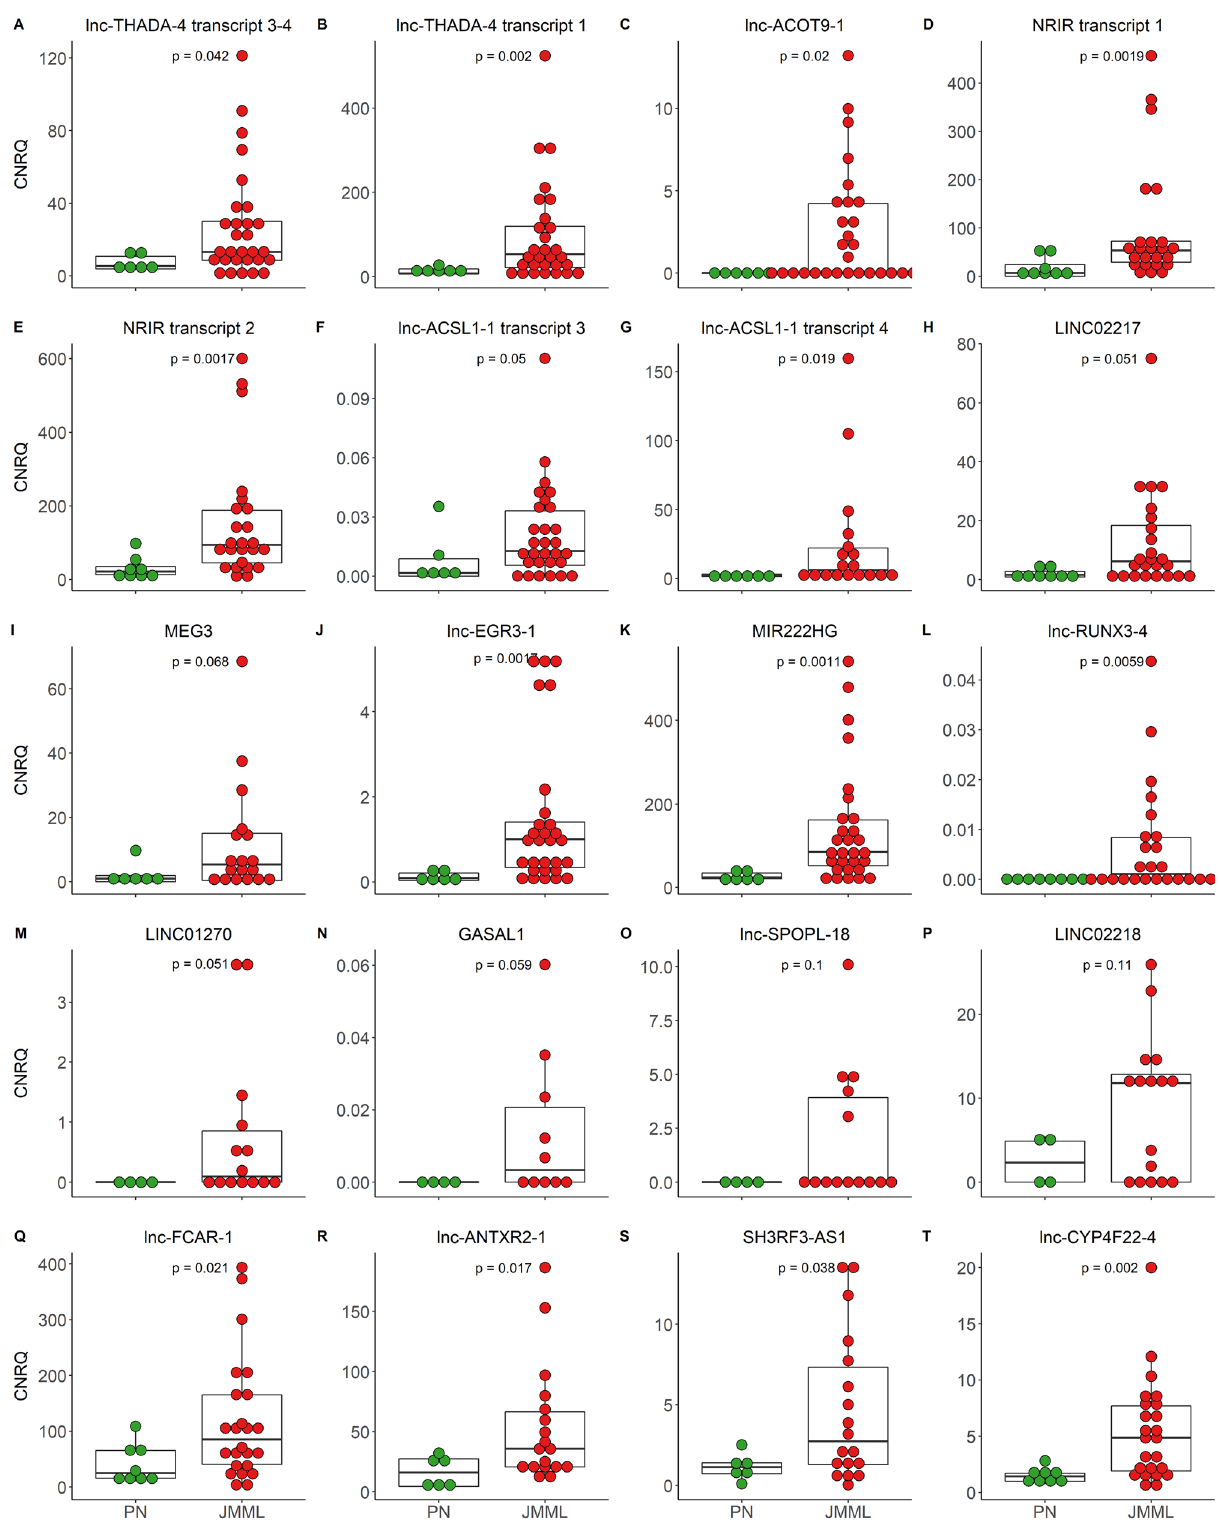
Figure 2. qPCR validation of the most significant differentially expressed lncRNAs discovered by RNA sequencing. qPCR confirmed significant upregulation of 12/45 (29%) and near significant upregulation of 6/45 (15%) lncRNA genes in JMML patients (n = 14 to 29) compared to PN (n = 6). One-sided P values were calculated by the Mann–Whitney U test. Median values and quartiles are shown by horizontal lines. The vertical axis (y-axis) corresponds to the calibrated normalized relative quantities (CNRQ). TBP , HPRT1 and GAPDH were used as internal reference genes. qPCR quantitative reverse transcriptase PCR, JMML juvenile myelomonocytic leukemia, PN pediatric normal, lncRNA long non-coding RNA, CNRQ calibrated normalized relative